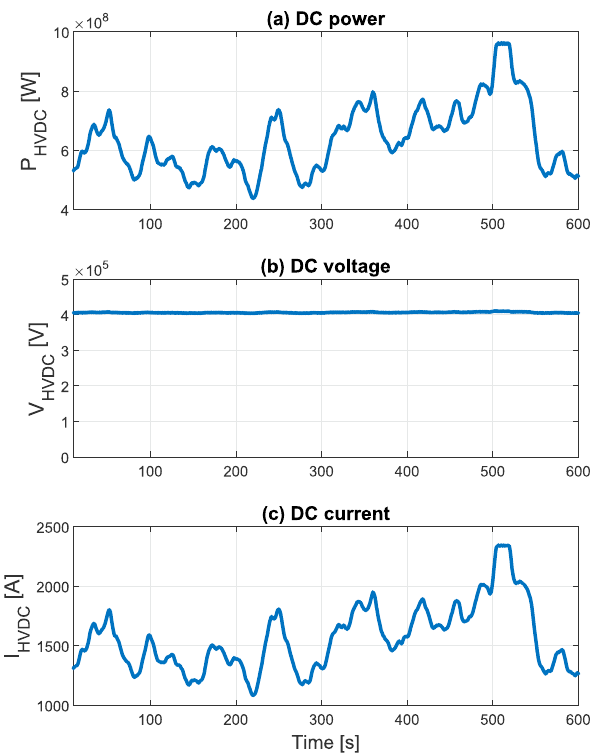
Figure 19. DC-side variables: ( a ) power, ( b ) voltage, and ( c ) current.